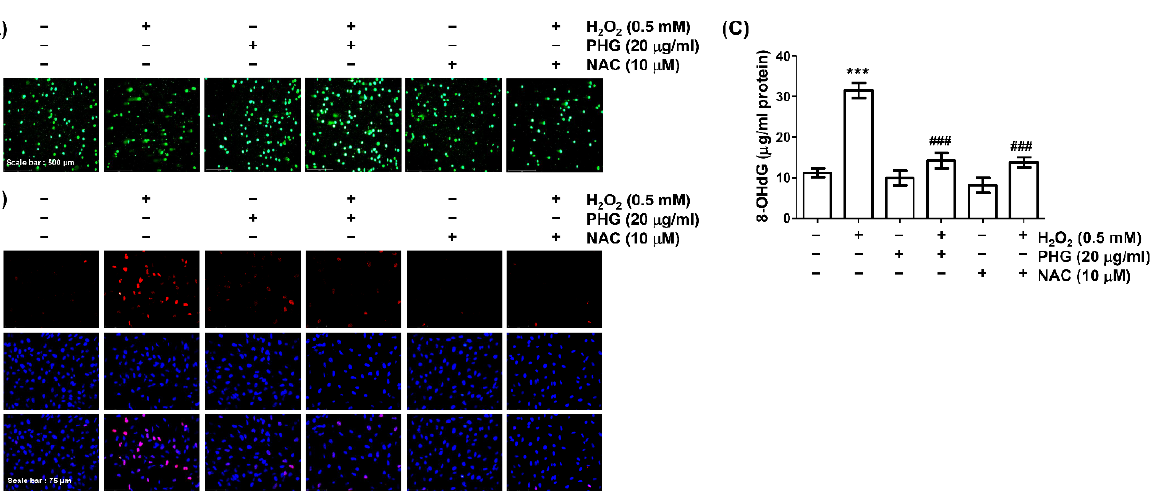
Figure 3. Phloroglucinol suppresses H 2 O 2 -induced reactive oxygen species (ROS) production in ARPE-19 cells. Cells treated with or without phloroglucinol or NAC for 1 h were stimulated with H 2 O 2 for another 1 h. After 2′ , 7′ -dichlorofluorescein diacetate (DCF-DA) staining, ROS generation level was investigated through flow cytometry ( A , B ) and fluorescence microscopy ( C ). Representative histograms ( A ) and quantitative analysis ( B ) are shown. ( C ) Representative images of DCF-DA fluorescence are presented. *** p < 0.001 vs. unstimulated control; ### p < 0.001 vs. H 2 O 2 alone treatment.3.4. Phloroglucinol Abolishes H 2 O 2 -Induced DNA Damage.